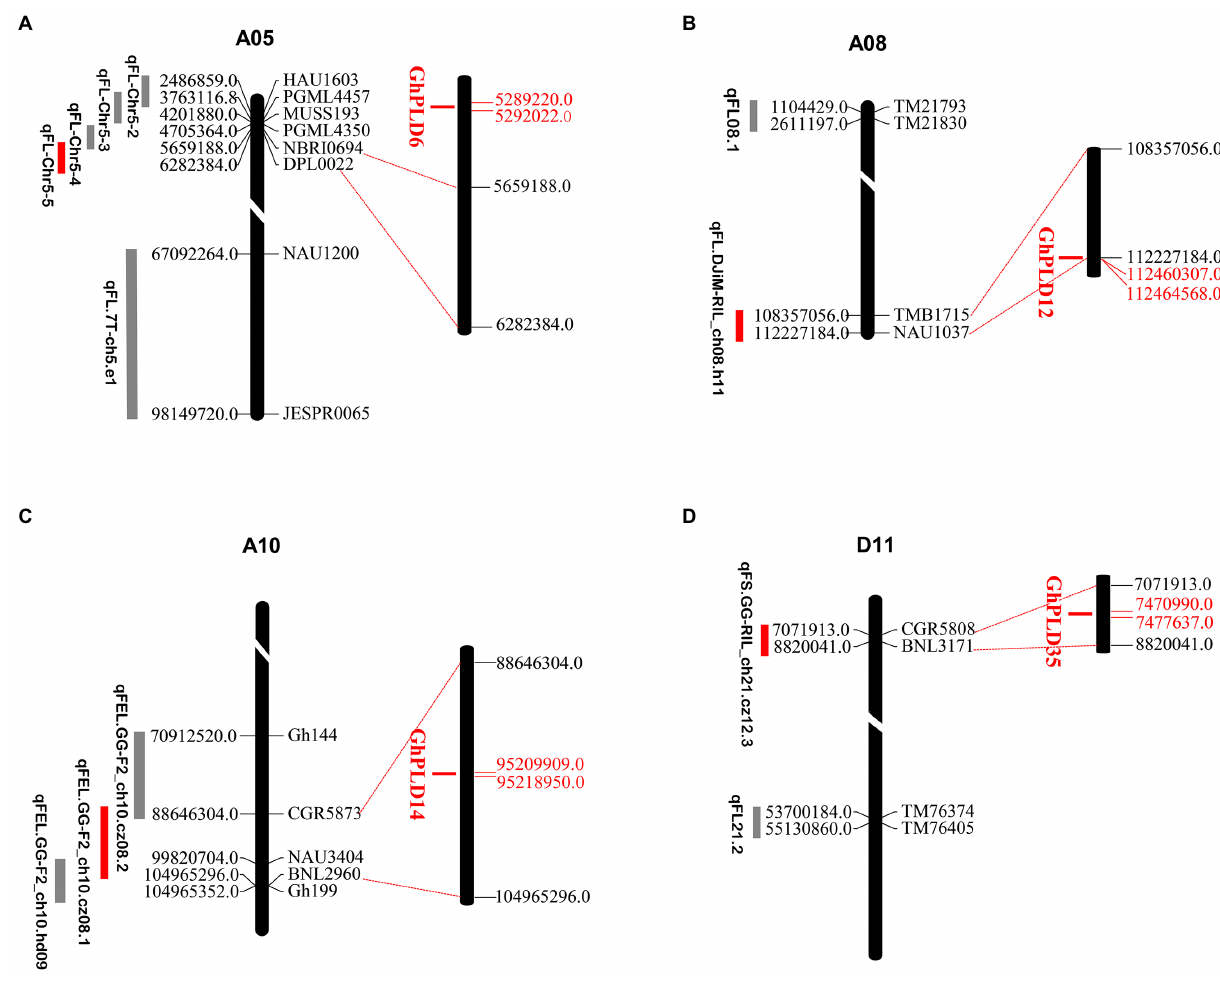
FIGURE 2 | Distribution of co-localized GhPLD s on the A05 (A) , A08 (B) , A10 (C) , and D11 (D) chromosomes of G. hirsutum . The scale indicates the position of PLD genes and quantitative trait locus (QTL)-linked markers in the chromosome. The unit is megabase (Mb). QTLs related to fiber length (FL), fiber elongation (FE), and fiber strength (FS) are shown. GhPLD genes that co-localize with QTLs of different fiber traits are indicated in